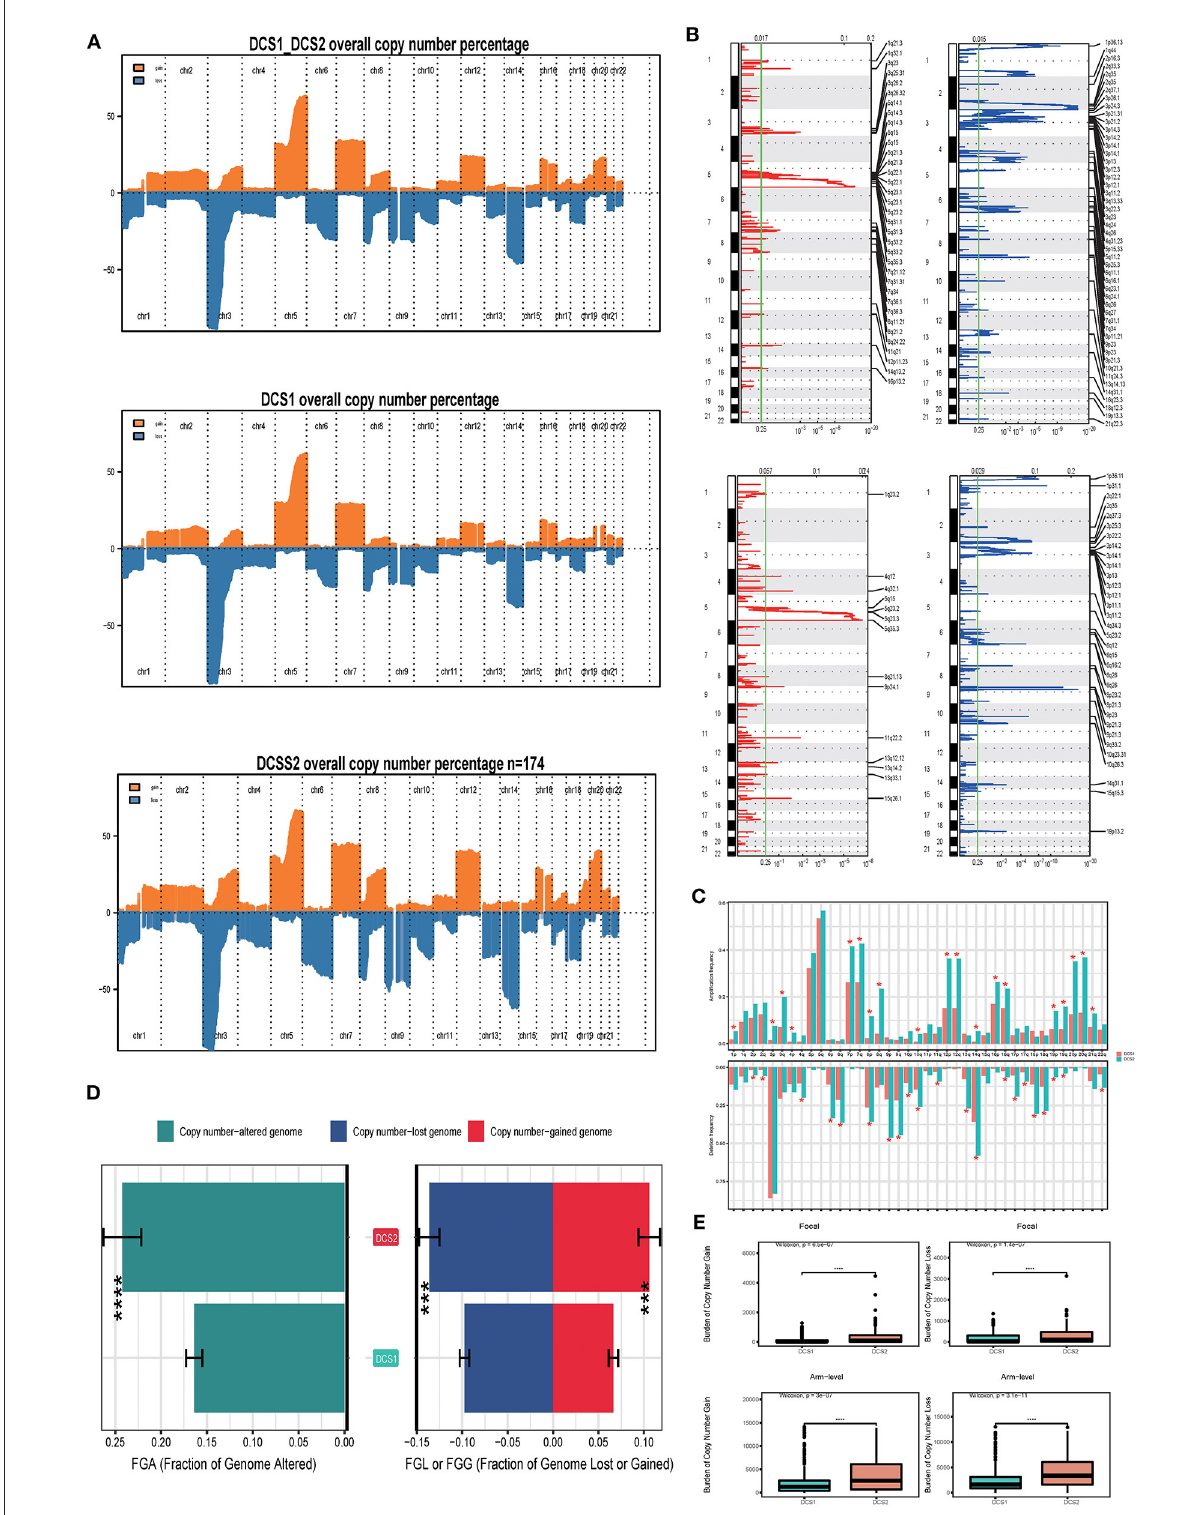
FIGURE6 Landscapes of copy number variations. (A) Comparison of overall copy number among all patients, DCS1 and DCS2. Orange represents genomic gain; blue represents genomic loss. (B) Detailed specific amplification or deletion sites between subtypes. Up represents DCS1;